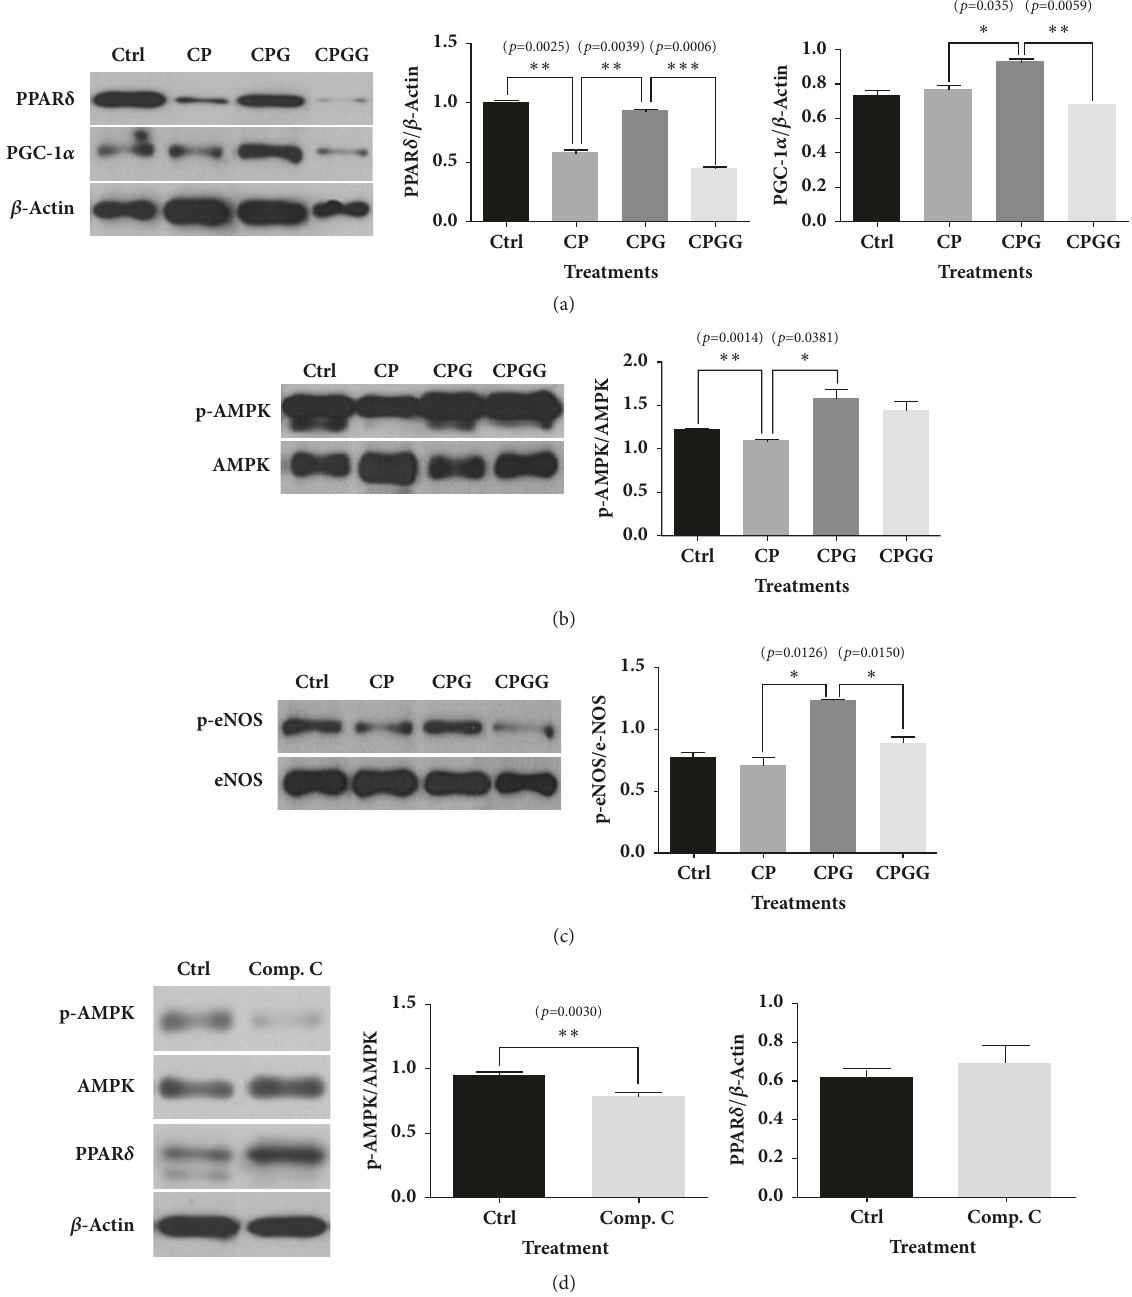
Figure 2: W estern b l o t anal y ses fo r PPAR 𝛿 , AMP K, an d eNOS in HUVE Cs treate d w it h c ho lester o l , p almitate , 6 - g in g er o l , GS K0660, an d c o m pou n d C. (a, b, c) 6-Gingerol ameliorated the levels of PPAR 𝛿 , AMPK, and eNOS abnormally expressed in HUVECs treated